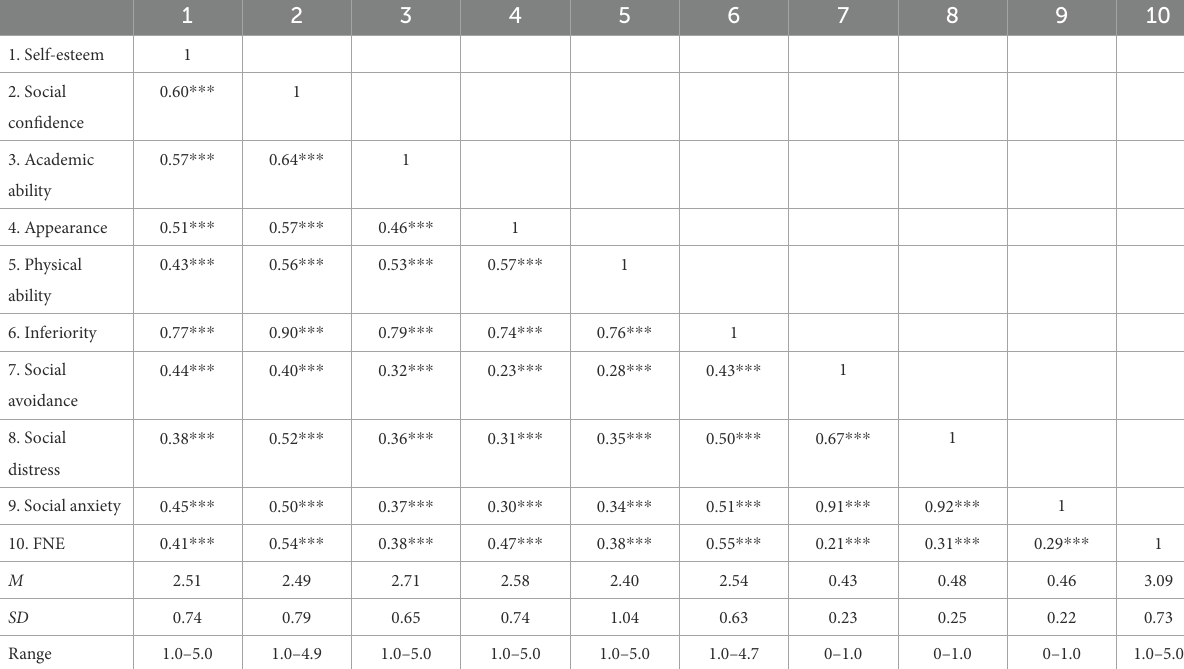
TABLE 2 Correlation matrix among variables ( n = 734).